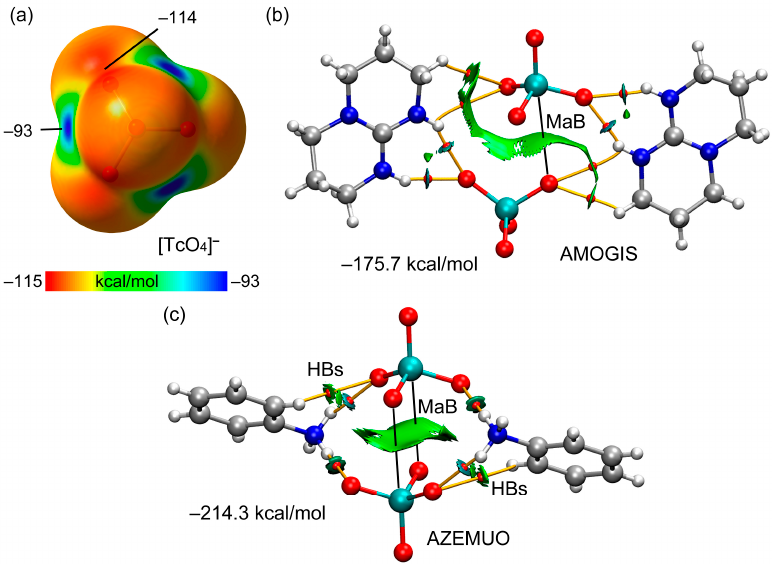
Figure 2. ( a ) MEP surface of [TcO 4 ] − (isosurface 0.001 a.u.). Energies at selected points in kcal/mol. ( b ) QTAIM/NCIPlot analysis of the tetramers of AMOGIS ( b ) and AZEMUO ( c ) with indication of the association energies. Only the bond CPs corresponding to the HBs are shown. Additional bond CPs interconnecting the O-atoms of the anions have been omitted for clarity. Color code: Carbon grey, Oxygen red, Nitrogen blue, Technetium teal, Hydrogen light